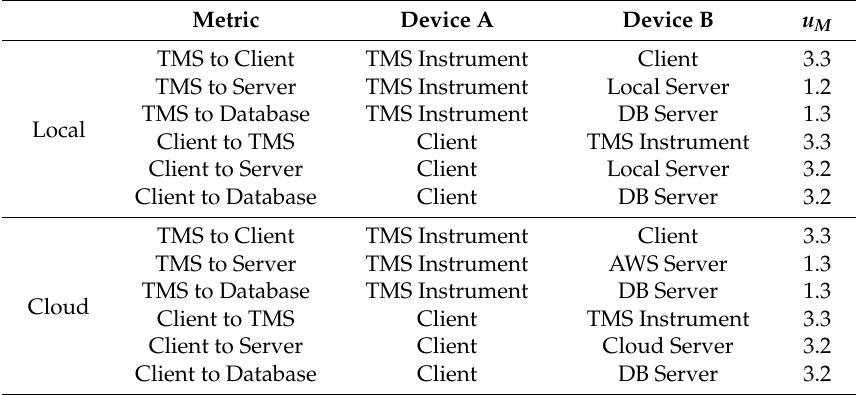
Table 3. Synchronization uncertainty related to the metrics used in the experiments (ms). Metric